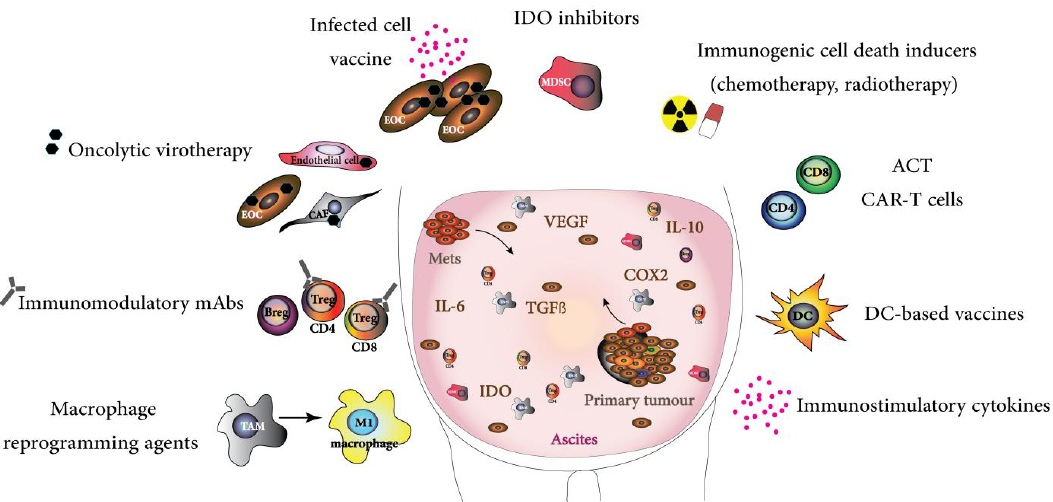
Figure 1. Emerging ovarian cancer immunotherapies. T cell infiltrated EOCs (>50% EOCs [120] can be targeted with therapies such as ACT, CARs cells, co-stimulatory mAbs [121] (like anti-CD137), oncolytic virotherapies, and DC-based vaccines [122], aiming to increase the effector functions of the pre-existing antitumoral immunity. Conversely, strategies aiming to decrease the highly immunosuppressive TME [checkpoint blockers mAbs (anti-PD-L1), IDO inhibitors [123], etc.] can be exploited for ‘cold’ tumors and/or for advanced stages EOC, to decrease the immunosuppressive functions of MDSCs, TAMs, and Tregs. Radiotherapy and chemotherapy are immunogenic cell death inducers increasing the release of TAAs in the TME, thus augmenting the NK-cell mediated killing, the incidence of TAA presentation by APCs, and eventually T cell priming. Also, chemotherapy can target MDSCs (gemcitabine [124], 5-fluorouracil [125]). EOC cells and TAMs can be targeted with trabectedin, which inhibits CCL2 production and decreases monocyte recruitment in tumors [126]. OVs can infect tumor cells, as well as CAFs and endothelial cells, thereby helping to decrease their immunosuppressive action in the TME. Many approaches can be combined, such as administration of costimulatory cytokines (IL-2, IL-7, IL-15 and IL-21) along with approaches such as CARs, OVs, and ACT. Tumor cells derived from ascites can be exploited for the production of infected cell vaccines with OVs delivering IL-12. Simultaneous targeting of CD137 and PD-1 [127] or TIM-3 [128] with mAbs along with cisplatin treatment [129] can achieve significant antitumoral responses. Adoptive cell transfer (ACT), cancer-associated fibroblasts (CAFs), chimeric antigen receptor (CAR), monoclonal antibodies (mAbs), natural killer (NK), myeloid-derived suppressor cell (MDSC), tumor associated macrophage (TAM), regulatory T cells (Tregs), tumor associated antigen (TAA), antigen presenting cell (APC), oncolytic virus (OV), programmed cell death 1 (PD-1), T-cell immunoglobulin and mucin domain 3 (TIM-3), metastasis